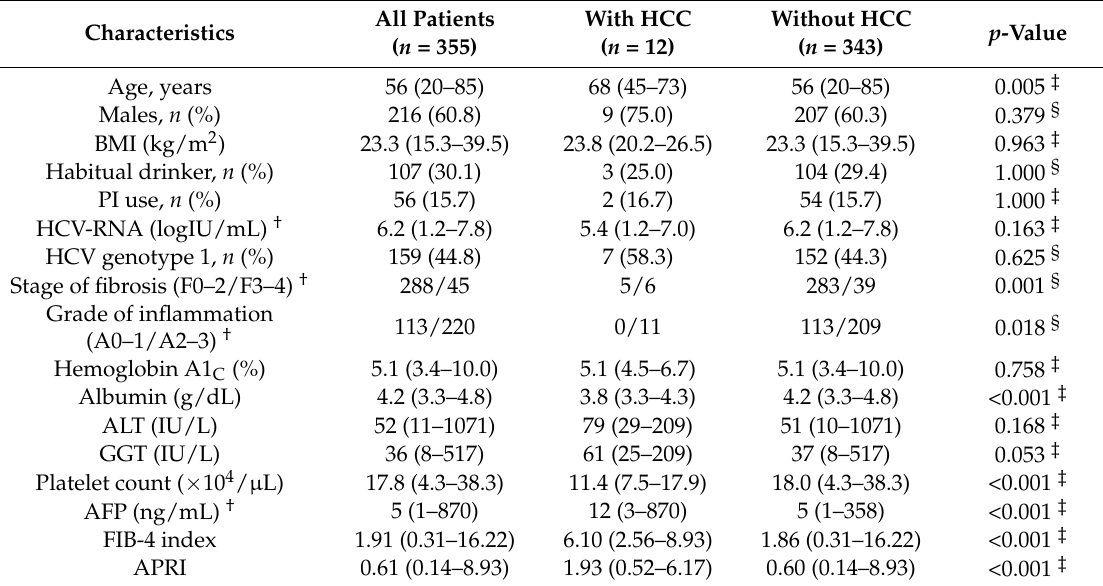
Table 1. Baseline characteristics of patients enrolled in the study.